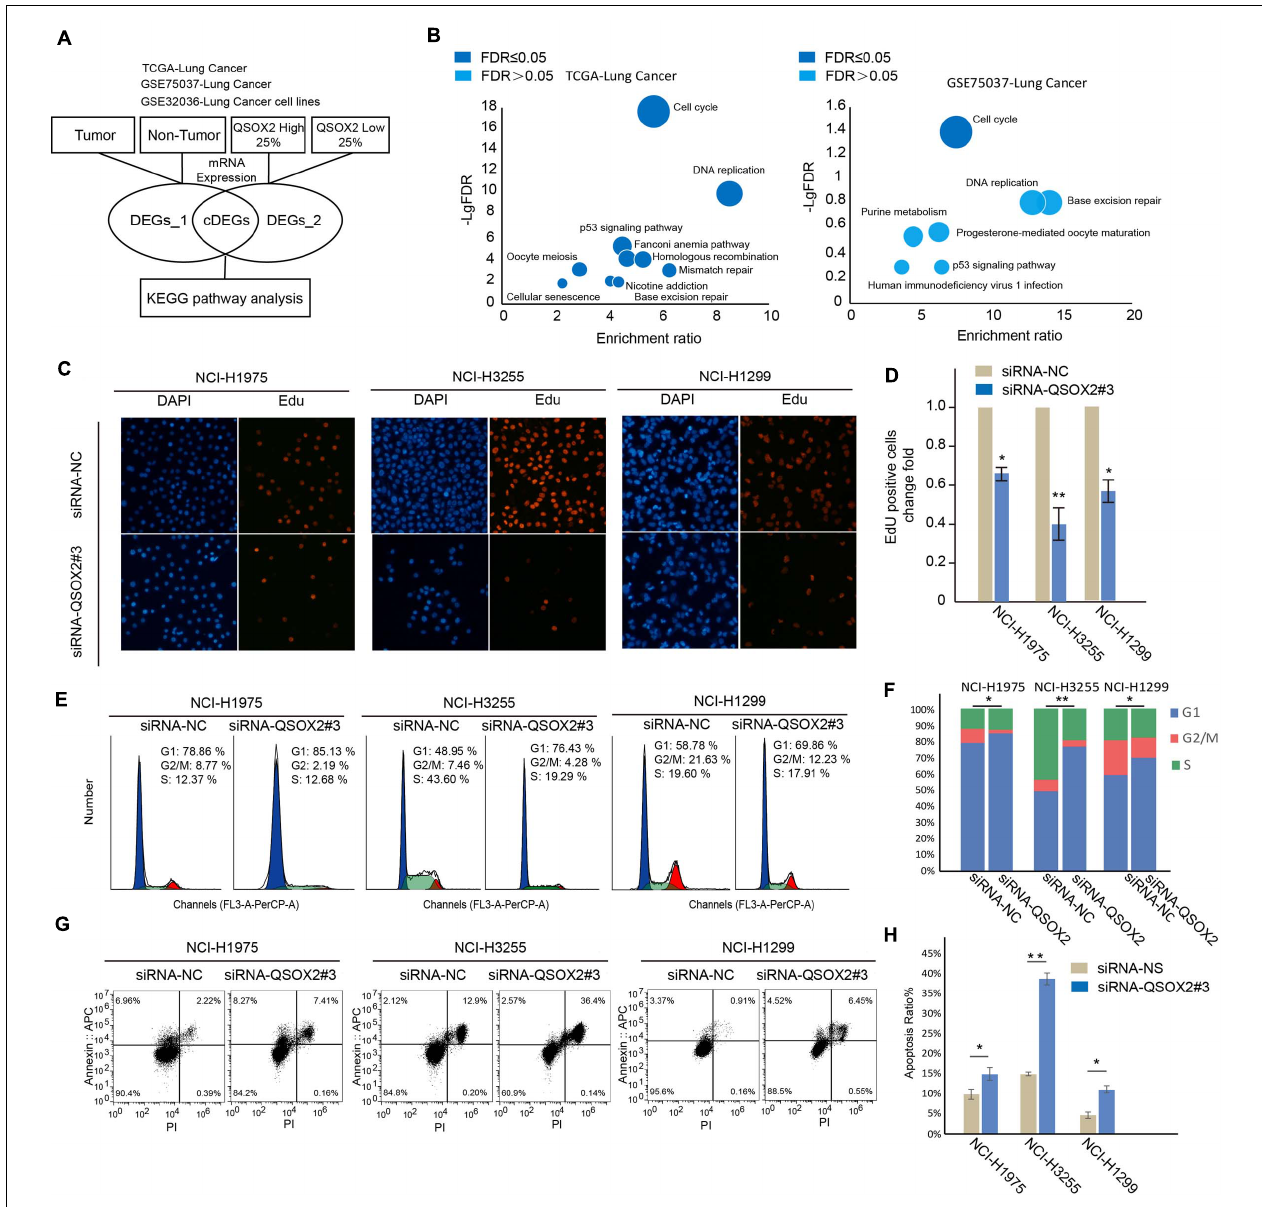
FIGURE 3 | Downregulation of QSOX2 expression represses the proliferation, cell cycle and survival of NSCLC cells. (A) DEG and KEGG pathway analyses of TCGA and GEO datasets. The bioinformatic data analysis workflow consisted of three publicly available datasets. (B) KEGG enrichment bubble chart. Negative log base 10 FDR values from the pathway enrichment analysis are plotted. Dark blue: FDR < 0.05; light blue: FDR ≥ 0.05. (C,D) NSCLC cells transfected with the indicated plasmids and subjected to EdU assays. Quantitative analysis was performed using ImageJ software. The bar graph shows the mean ± SD; n = 3, * P < 0.05, ** P < 0.01. (E,F) NSCLC cells transfected with the indicated plasmids for 48 h and subjected to cell cycle assays. The percentage of cells in each phase of the cell cycle was quantified in an accumulated histogram. * P < 0.05. (G,H) NSCLC cells transfected with the indicated plasmids and subjected to apoptosis assays. Quantitative analysis was performed using FlowJo software. The bar graph shows the mean ± SD; n = 3, * P < 0.05, ** P <